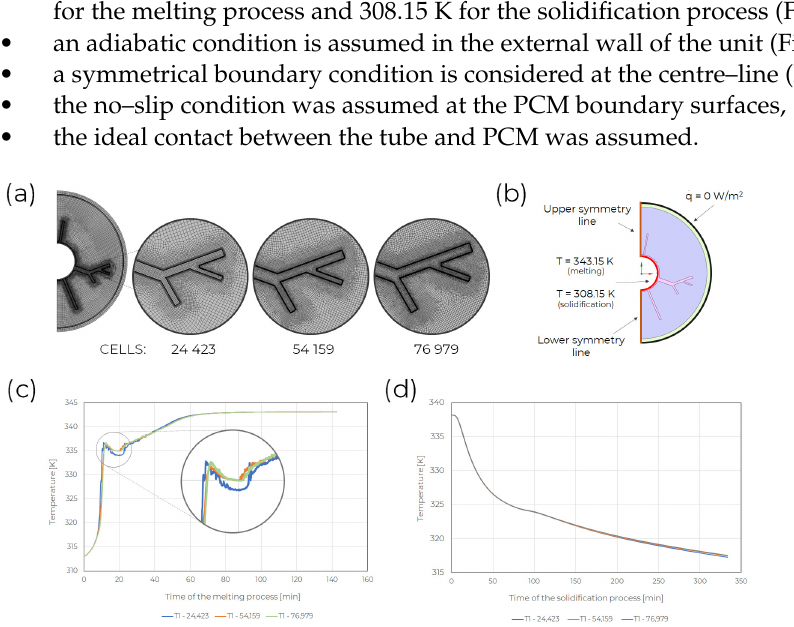
Figure 4. ( a ) The developed grids ( b ) Boundary conditions description, ( c ) The results of the grid independence test (solidification), ( d ) The results of the grid independence